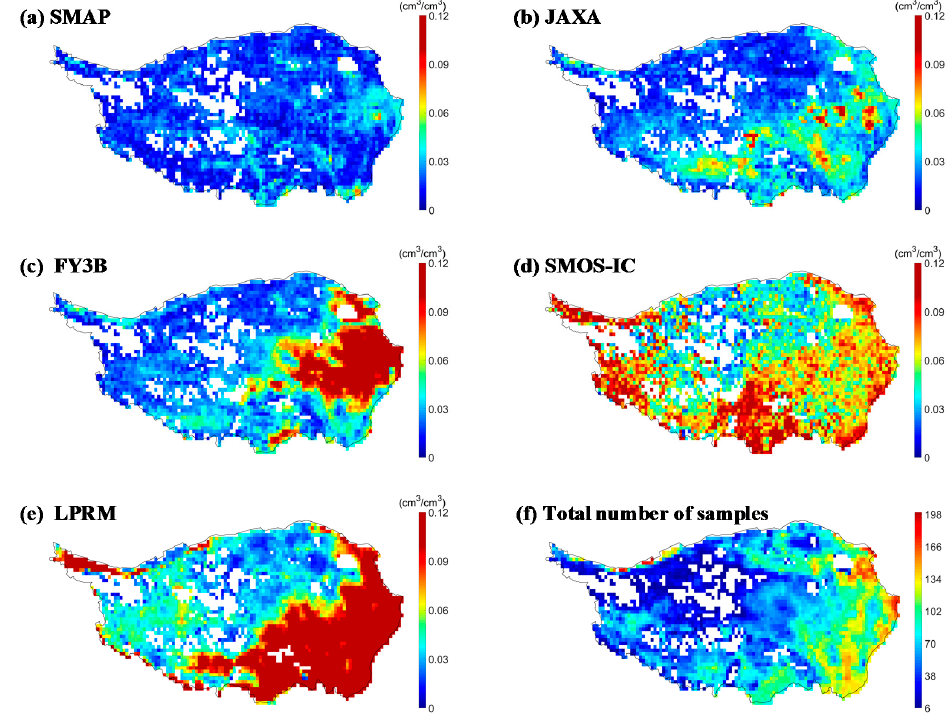
Figure 4. Uncertainty results of the five SM products ( a–e ) and ( f ) the total number of samples that were used in the three-cornered hat (TCH) method. The white areas indicate areas with no common samples or a sample size that was less than six.